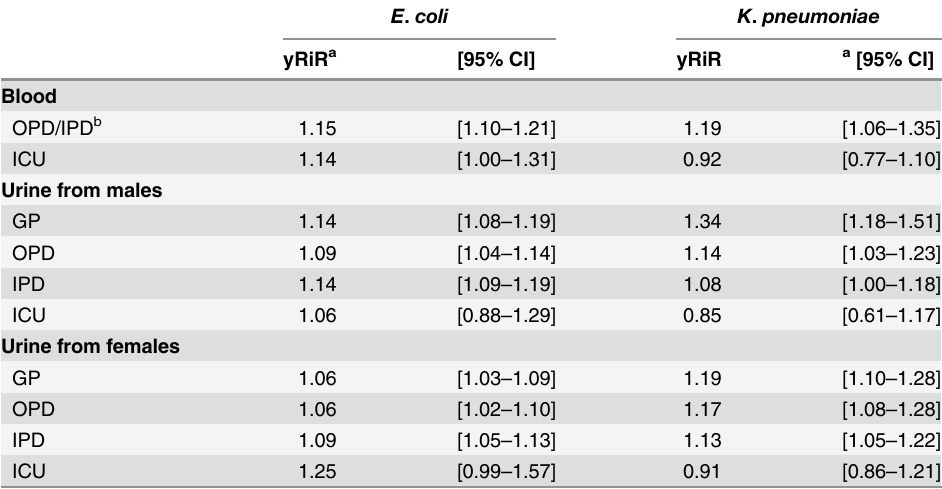
Table 3. Adjusted risk ratio ’ s (yRiR) per year for the time trends in proportion of Escherichia coli and Klebsiella pneumoniae isolates resistant to third generation cephalosporins per patient setting, ISI- S-AR, The Netherlands, 2008 –